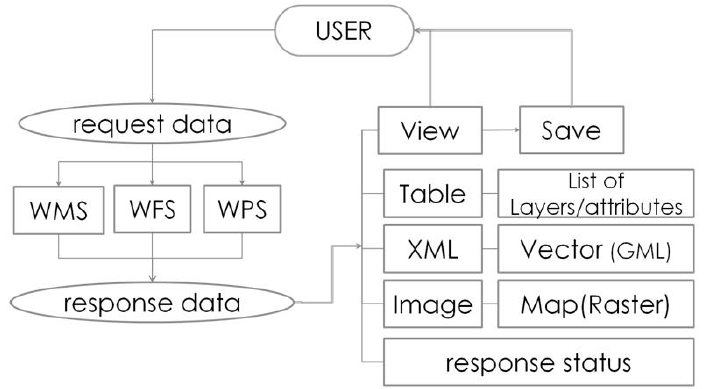
Figure 5. User interaction and data type results (Papadopoulos & Evangelidis, 2016).